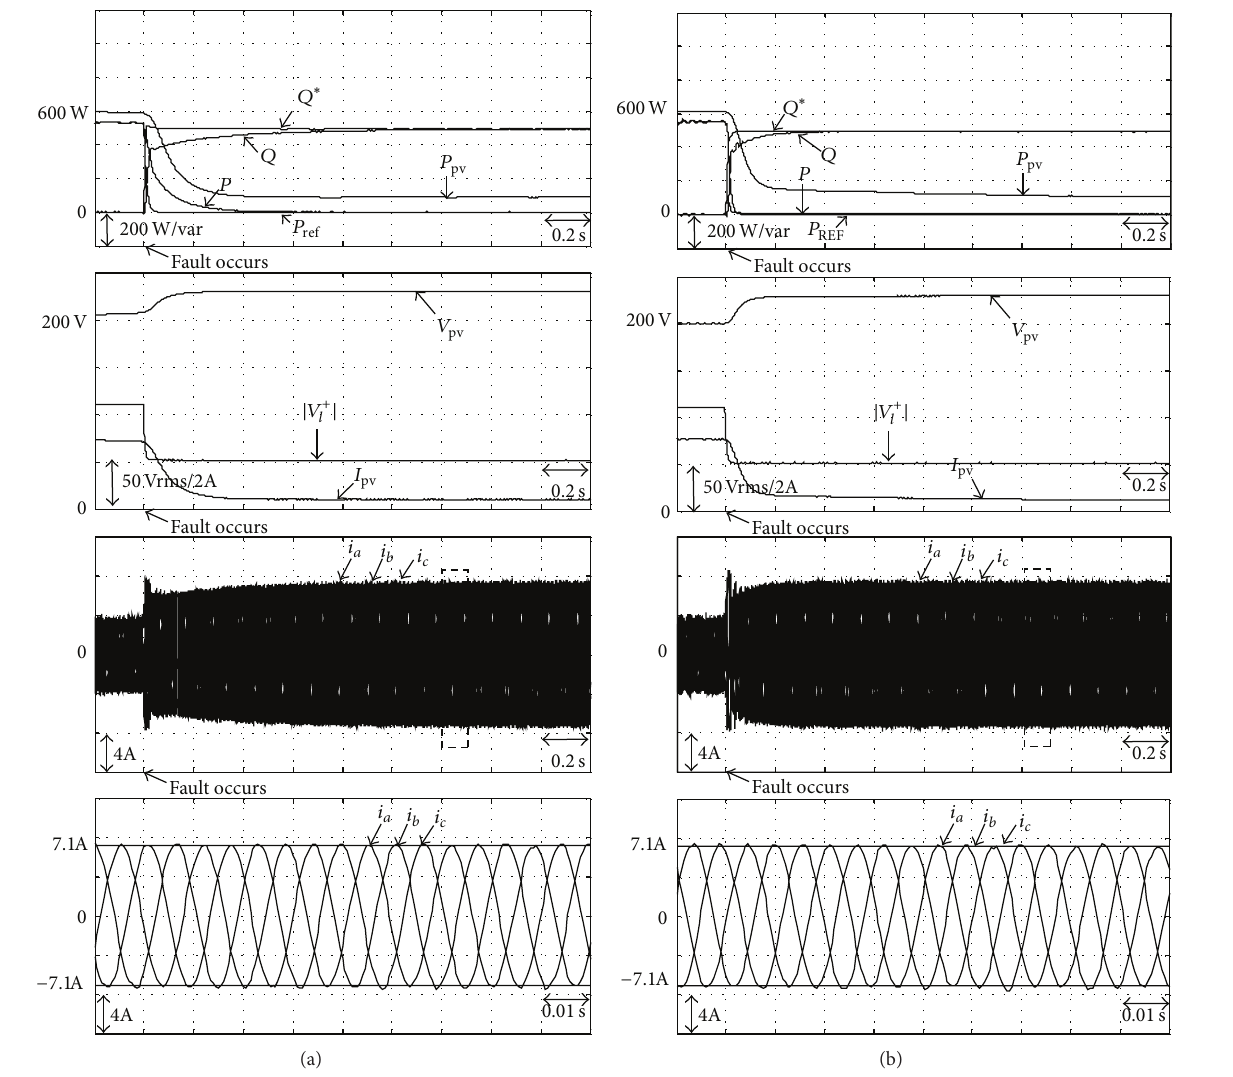
Figure 7: Experimental results of Case 2: (a) using PI controllers and (b) using 2D-RFCMANN